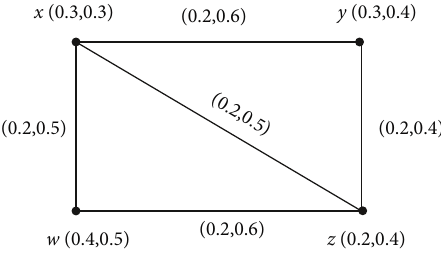
Figure 8: Connected vague graph ζ